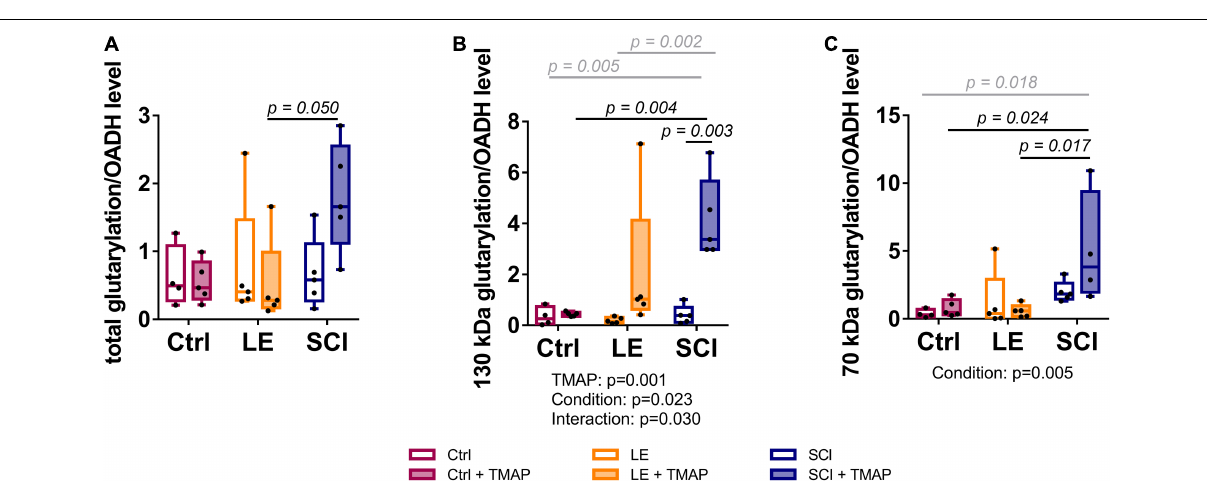
FIGURE 7 | Levels of brain protein glutarylation, normalized to OADH expression, in the rat cerebral cortex of the studied animal groups. Representative Western blots for estimation of relative glutarylation and OADH levels are shown in Supplementary Figures 2 , 3 , respectively. (A) Total protein glutarylation levels normalized to the sum of the expression of the two OADH isoforms. (B) Levels of glutarylation of 130 kDa proteins normalized to expression of 130 kDa isoform of OADH. (C) Levels of glutarylation of 70 kDa proteins normalized to expression of 70 kDa isoform of OADH. Statistically significant ( p < 0.05) differences between experimental groups, determined by two-way ANOVA with Tukey’s post-hoc test, are shown on the graphs. The black and gray colors correspond to the groups differing in one or two factors, respectively. Statistically significant ( p < 0.05) factors and their interactions, estimated by ANOVA, are shown as p -values below the